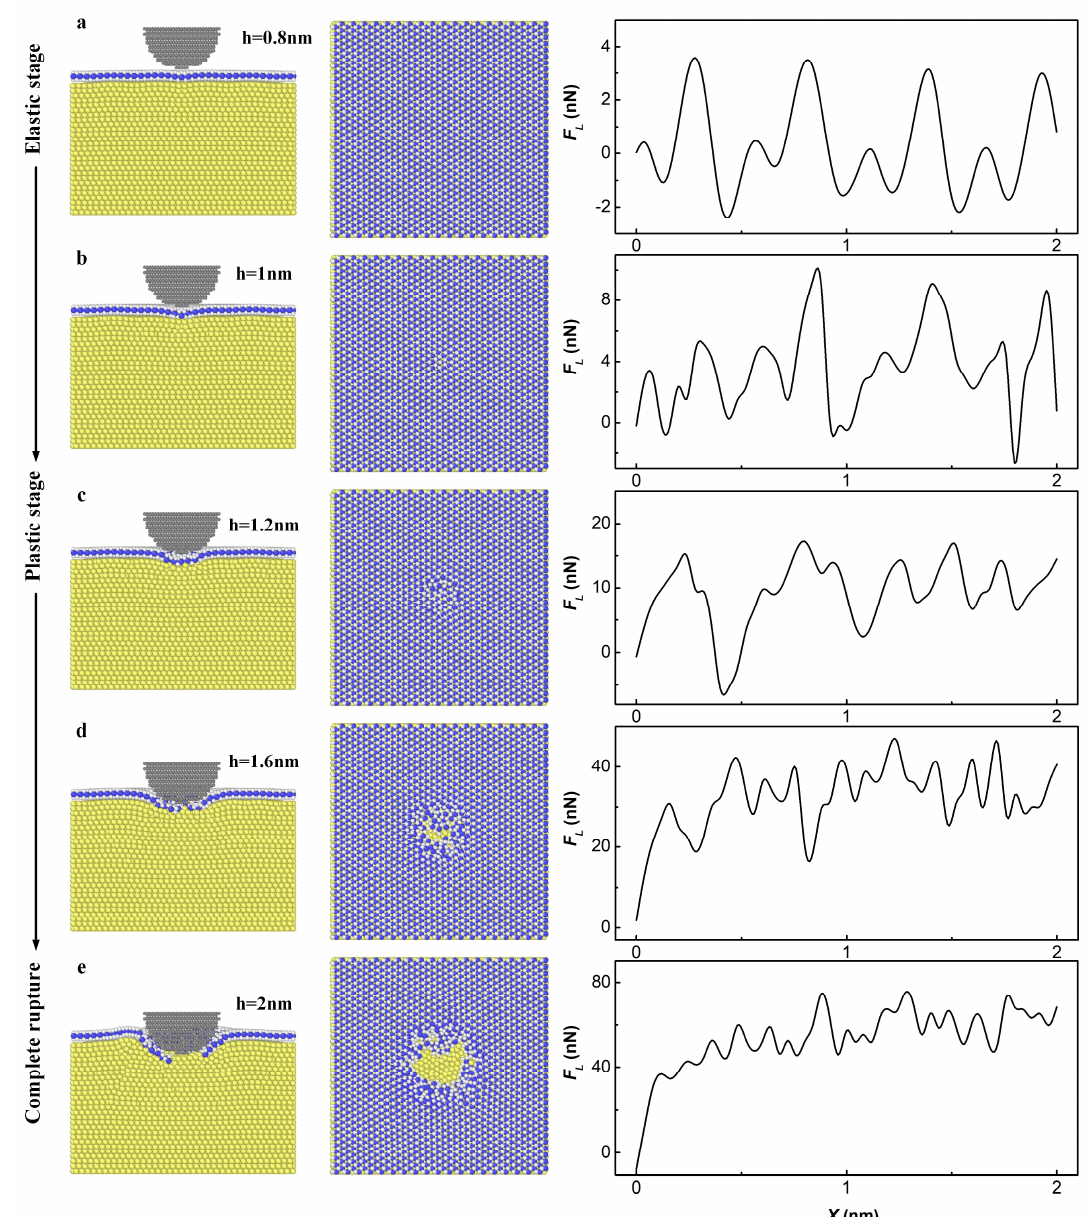
Figure 4. The left column shows the cutaway view of the simulation model, the middle column shows the top view of MoS 2 /Pt substrate and the right column shows variation of friction force with sliding distance at different indentation depth: ( a , b ) h = 0.8 and 1 nm, at elastic stage of MoS 2 monolayer; ( c , d ) h = 1.2 and 1.6 nm, at plastic stage of MoS 2 monolayer; ( e ) h = 2 nm, MoS 2 monolayer completely